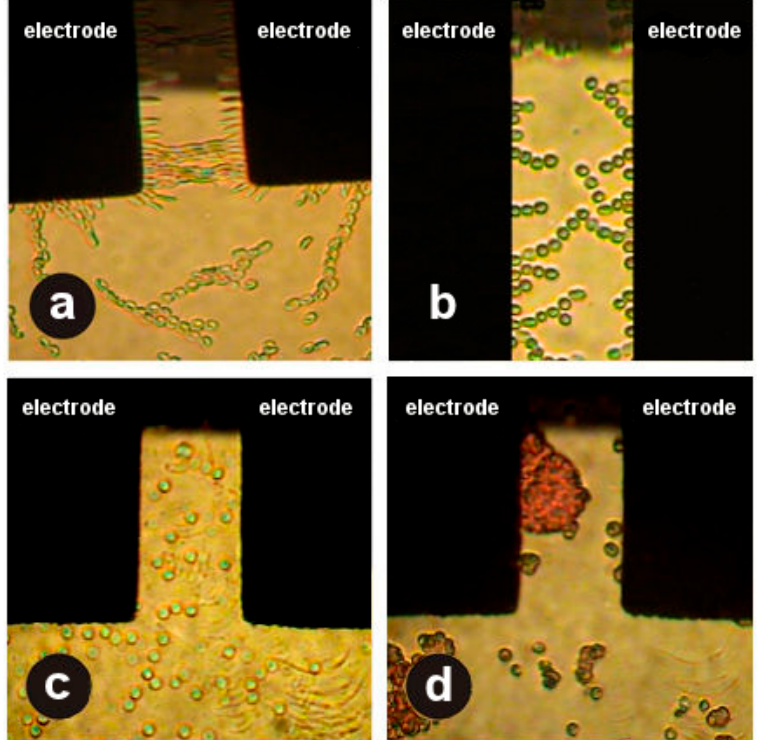
Figure 1. Behavior of red blood cells (RBCs) under the influence of the nonuniform alternating electric field (NUAEF) at a frequency of 10 6 Hz ( a ) in the healthy control group and ( b – d ) in patients with diabetes mellitus (DM) (see the main text).